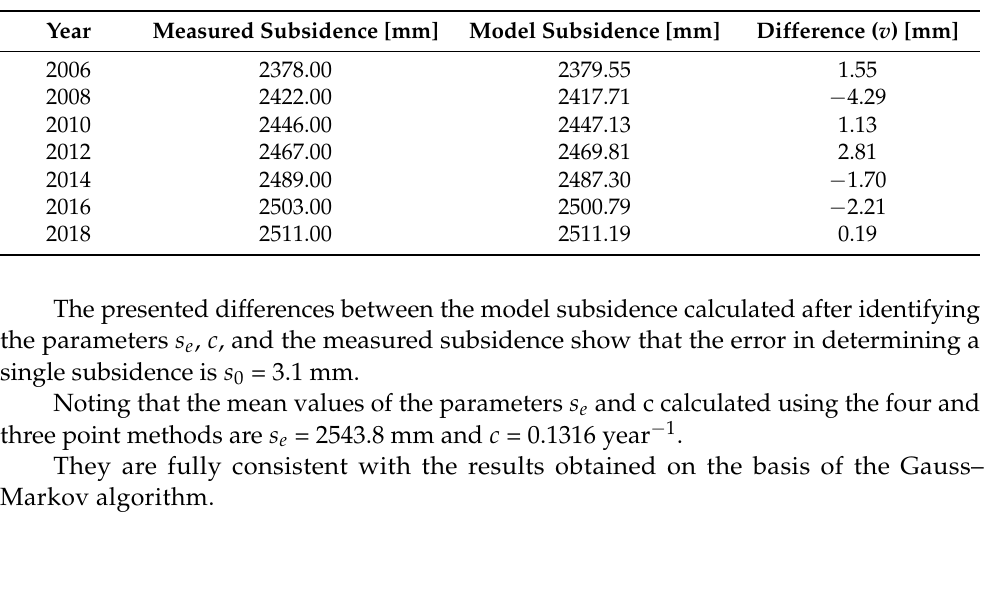
Table 4. Results of the subsidence obtained using the Gauss–Markov equalisation